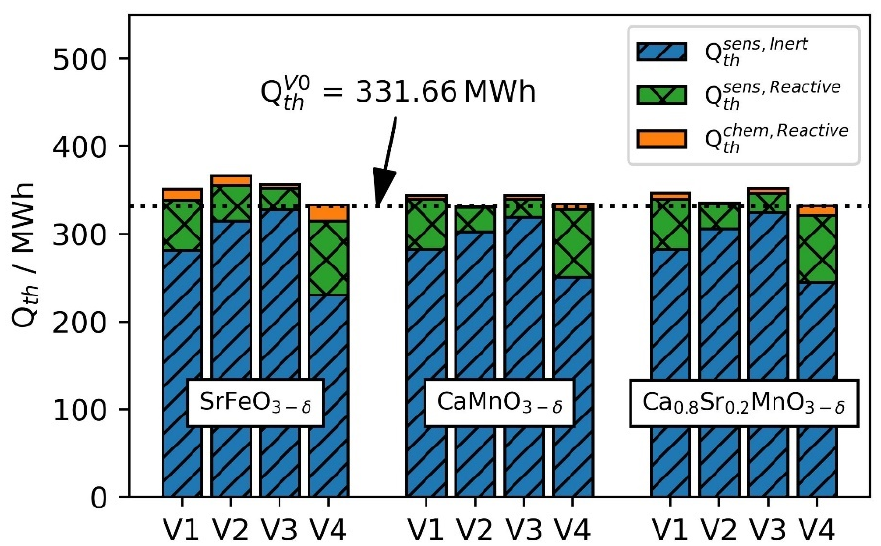
Figure 8. Thermal energy stored in the different cases investigated. The dotted horizontal line shows the thermal energy stored in the base case (V0) with an inert particle only.